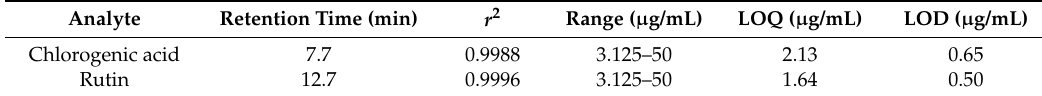
Table 2. HPLC data of calibration graphs and limit of quantification and detection of two markers. Analyte